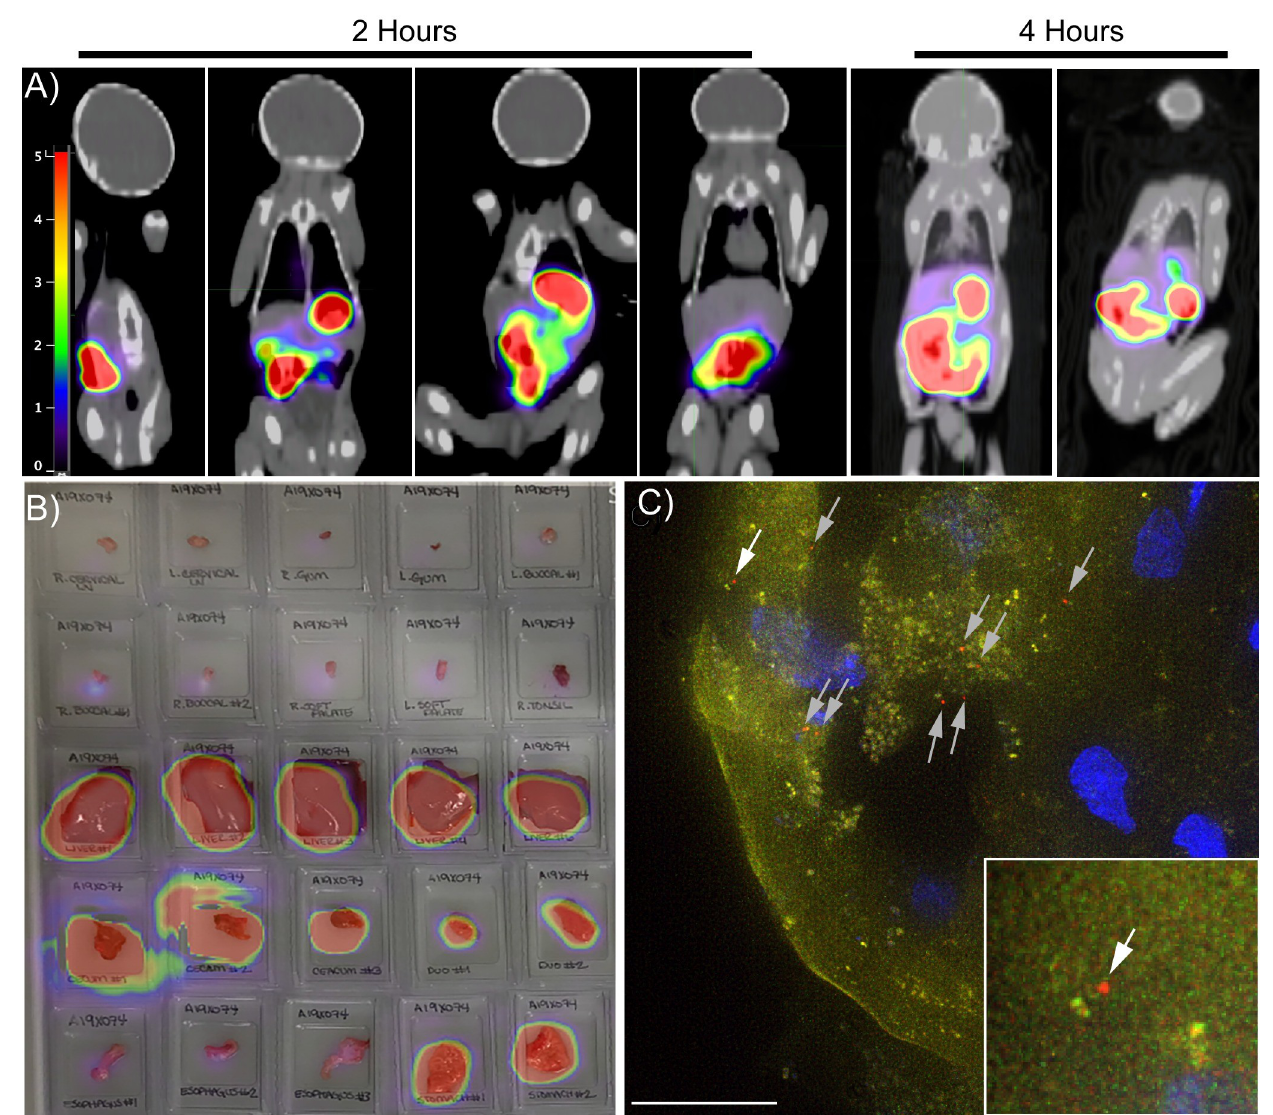
Fig 1. PET imaging follows distribution of PA-BaL- 64 Cu after oral viral challenge. Four animals were orally challenged with PA-GFP-BaL- 64 Cu. Two animals were sacrificed two hours post challenge and another two four hours post challenge, and the oral cavity and entire GI tract removed in one piece. The tissues were cut into pieces, frozen, cryosectioned, and prepared for fluorescent microscopy. A,B) Representative PET images of neonates after oral viral challenge with PA-GFP-BaL- 64 Cu. Scale in Standard Uptake Value (SUV) (A) Whole body PET images at two and four hours post-oral challenge. B) PET image overlayed on photograph of 25 individual tissue blocks from oral mucosa and GI tract four hours post-challenge. C) Representative fluorescent microscopy image showing individual HIV virions (red puncta indicated by arrows) penetrating the tongue of an animal that received PA-BaL- 64 Cu at two hours post-challenge. Green–pre-activation, Red–post-activation (virion), Blue–Hoechst. White arrow indicates virion shown in inset; grey arrows indicate other virions in the micrograph.